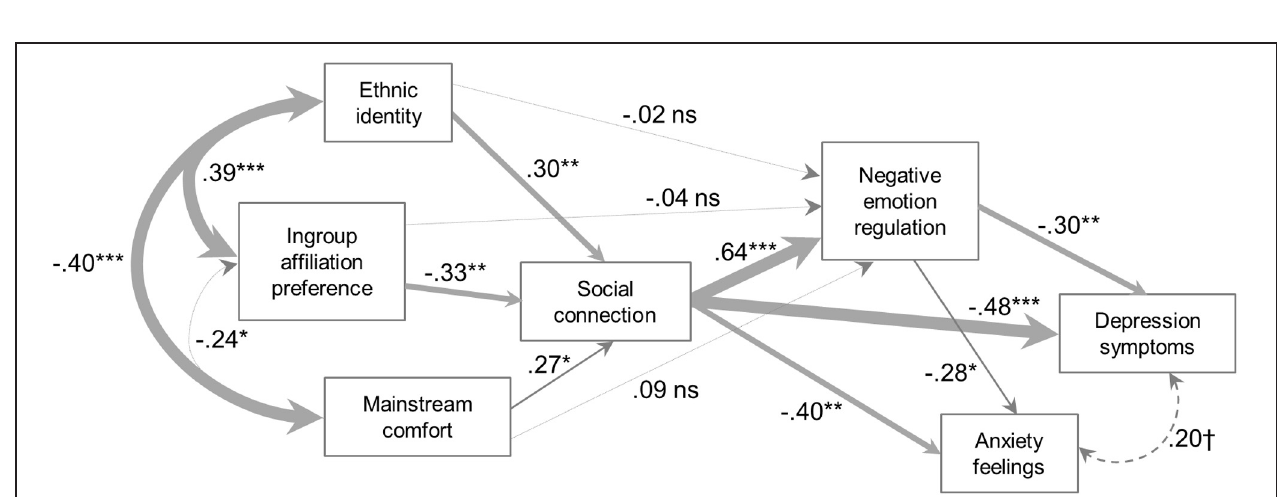
FIGURE 2 | Non-Hispanic White/European American (EA) participants ( N = 234).